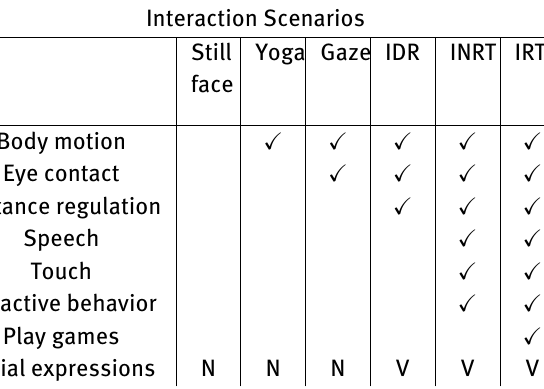
Table 1: The table shows the behavioral parameters used for each of the six interaction scenarios. The " (cid:88) " signifies the existence of that parameter. In the "Facial expressions" panel, N stands for "Neutral" facial expression, and V stands for "Varying" facial